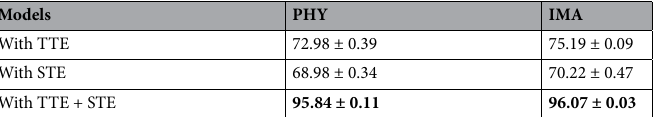
Table 5. Ablation study on the ETST model (without position encoding). Significant values are in